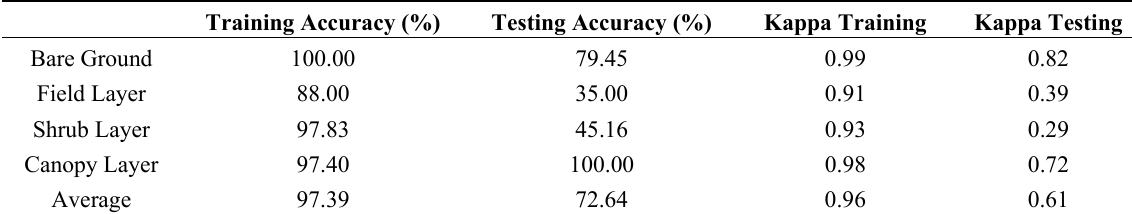
Table 3. Accuracy of vegetation